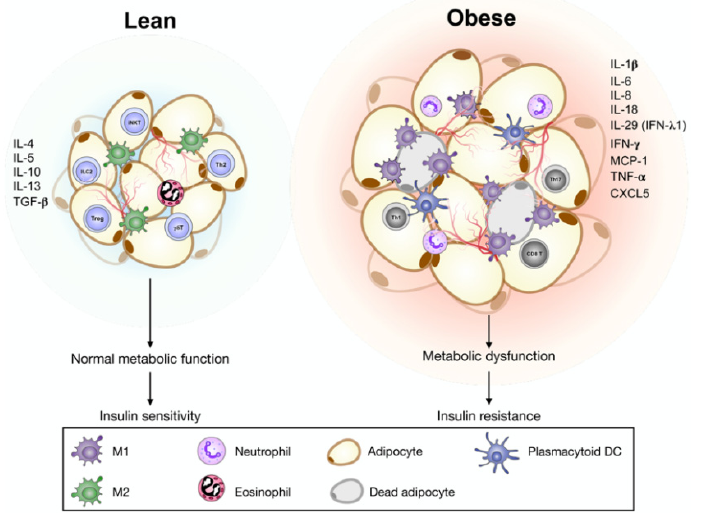
Figure 1. Adipocytes and immune cells act cooperatively to produce cytokines, chemokines, and interferons, contributing to obesity-related inflammation and metabolic dysregulation in human adipose tissue.